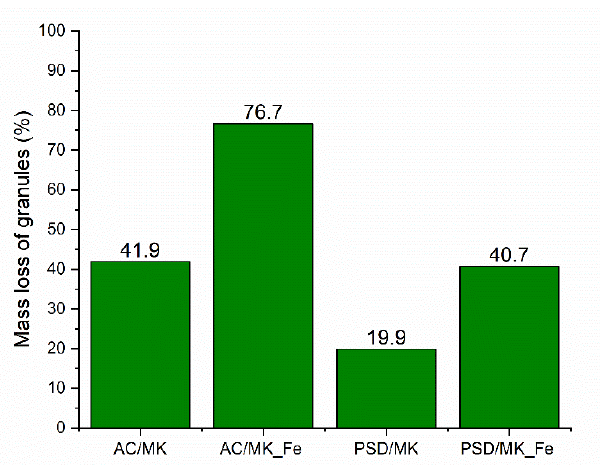
Figure 6. Mass loss of the studied catalyst materials at CWAO reaction conditions: p (air): 20 bar, c (BPA): 60 mg/L, c (catalyst): 1 g/L T: 160 °C, 800 rpm.